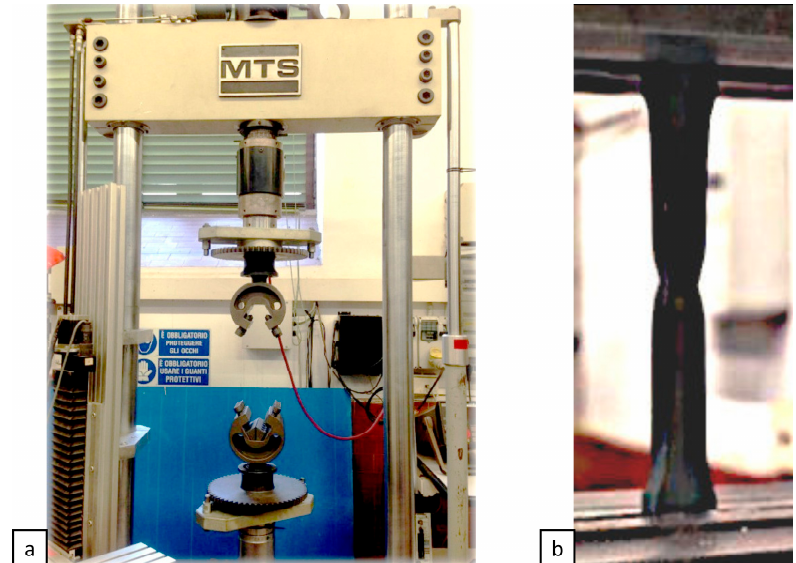
Figure 4. Experimental setup: ( a ) universal testing machine; ( b ) necked specimen just before fracture. Table 3. Specimens IDs, actual dimensions and postprocessing information.